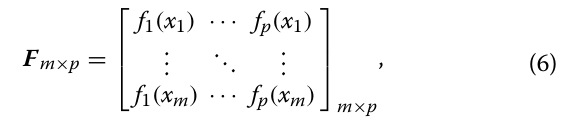
where the basis function f ( x ) has several forms. Usually, constant and linear forms of the regression function are used to construct the basis function [33].